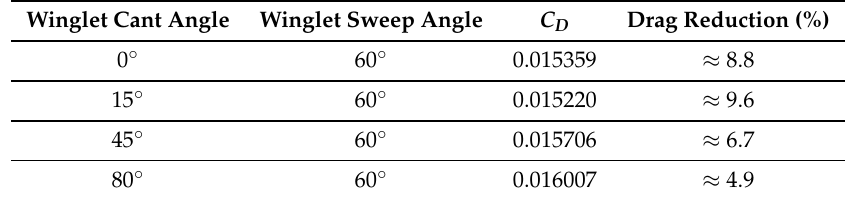
Table 4. C D and drag reduction percentage for a target C L equal to 0.2. The drag reduction percentage was computed with respect to the baseline wing (positive values indicate drag reduction). Winglet Cant Angle Winglet Sweep Angle C D